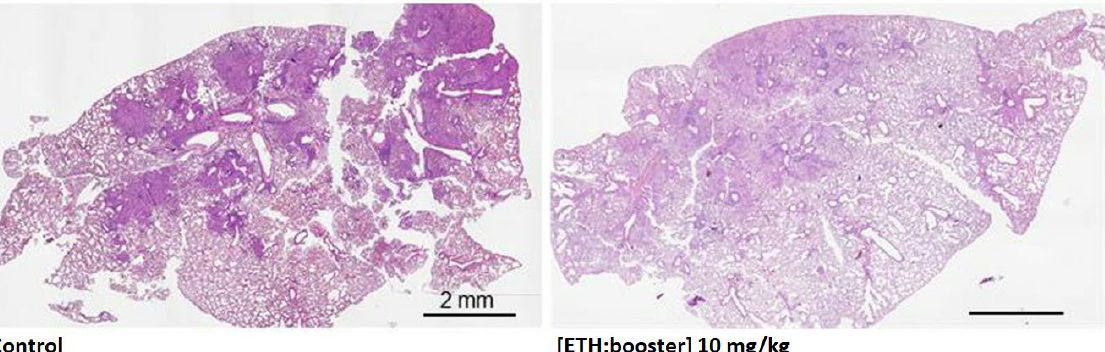
Figure 12. Histological sections of lungs from Mycobacterium tuberculosis -infected mice, untreated ( left ) or treated with β -cyclodextrin-based nanoparticles loaded with ethambutol (ETH) and BDM41906 (booster) 6 times in 2 weeks by the endotracheal route ( right ). Adapted from reference [127], used under Creative Commons BY 4.0 license.